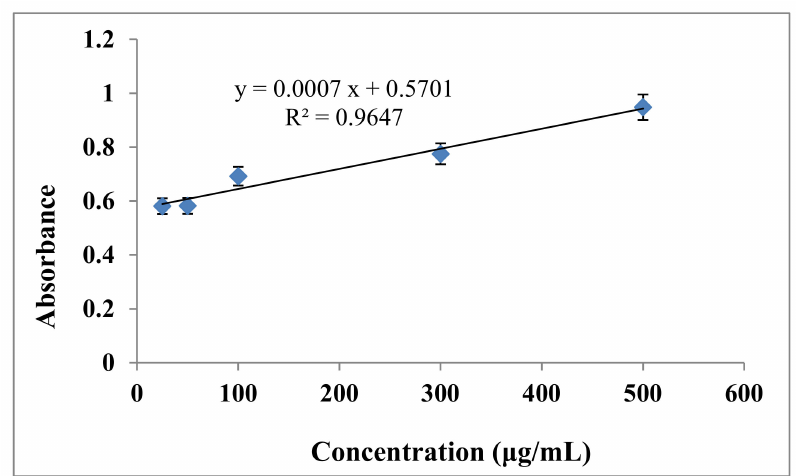
Figure 2. Quercetin standard calibration